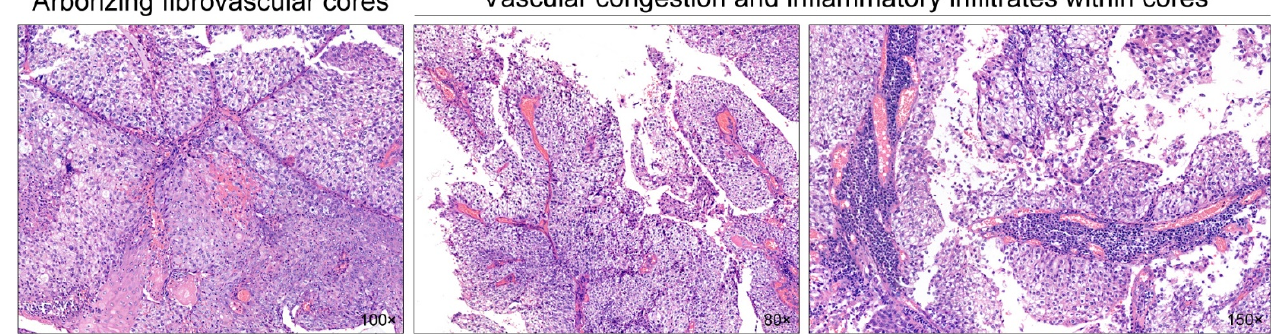
Figure 2. Gross and microscopic findings. Gross examination reveal an exophytic tumor (green arrowheads) arising from the right lateral aspect of the uterine cervix and protruding into the vaginal lumen. The cut surface show a papillary-appearing tumor (green arrowhead) with unapparent stromal invasion. On scanning magnification, the tumor is characterized by a predominantly exophytic growth towards the vaginal lumen. Numerous, variably-sized papillary fronds are richly vascularized and lined by stratified squamous epithelium. Finger-like protrusions or leaf-like structures and arborescent fibrovascular cores are frequently observed. The tumor papillae are either thin with a delicate fibrovascular core or broad with occasional vascular congestion and lymphoplasmacytic infiltrates. These histological features are consistent with papillary squamous cell carcinoma of the uterine cervix.